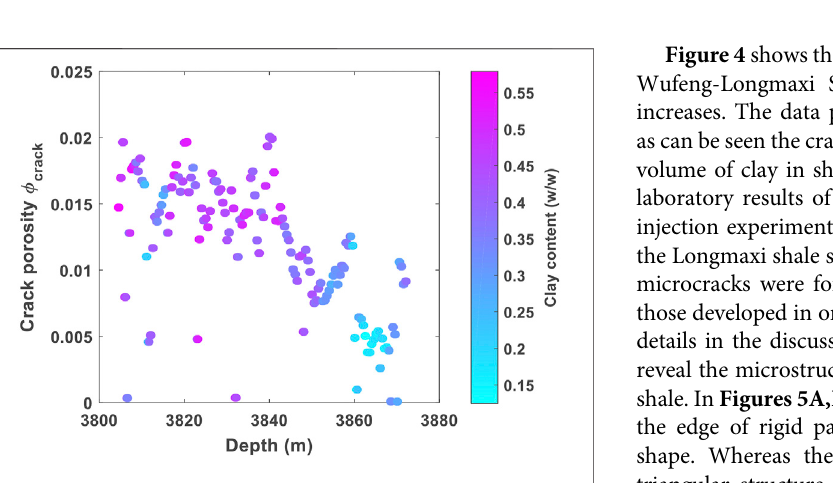
Frontiers in Earth Science |